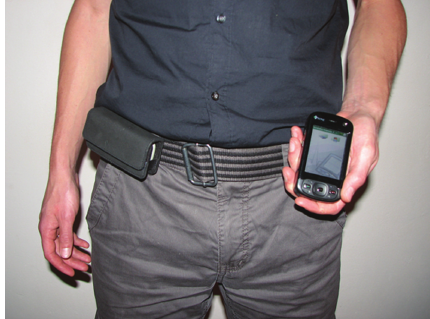
Figure 1: participant wearing the sensor on the belt and holding the smartphone.